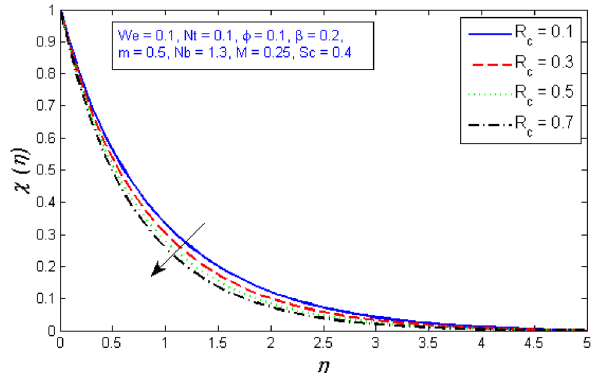
Figure 25. Represents variation of concentration profile for numerous number of Chemical reaction R c .